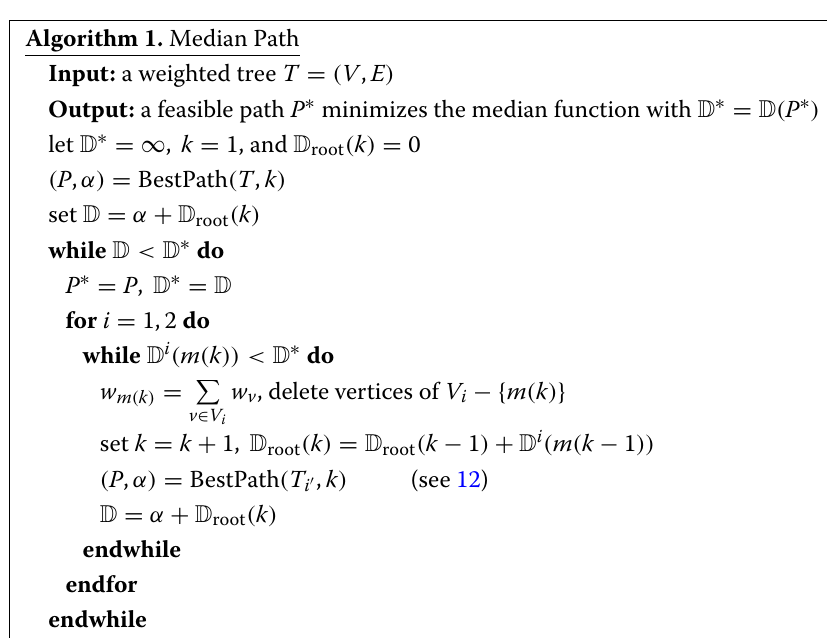
Algorithm 1. Median